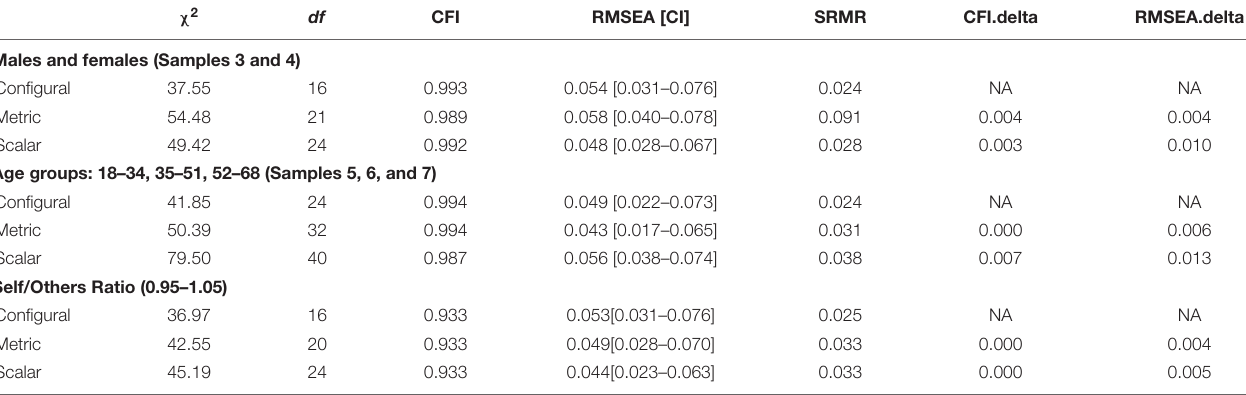
TABLE 5 | Study 3: Comparison of fit indices across gender, age, and Self/Others Ratio groups. χ 2 df CFI RMSEA [CI] SRMR CFI.delta RMSEA.delta